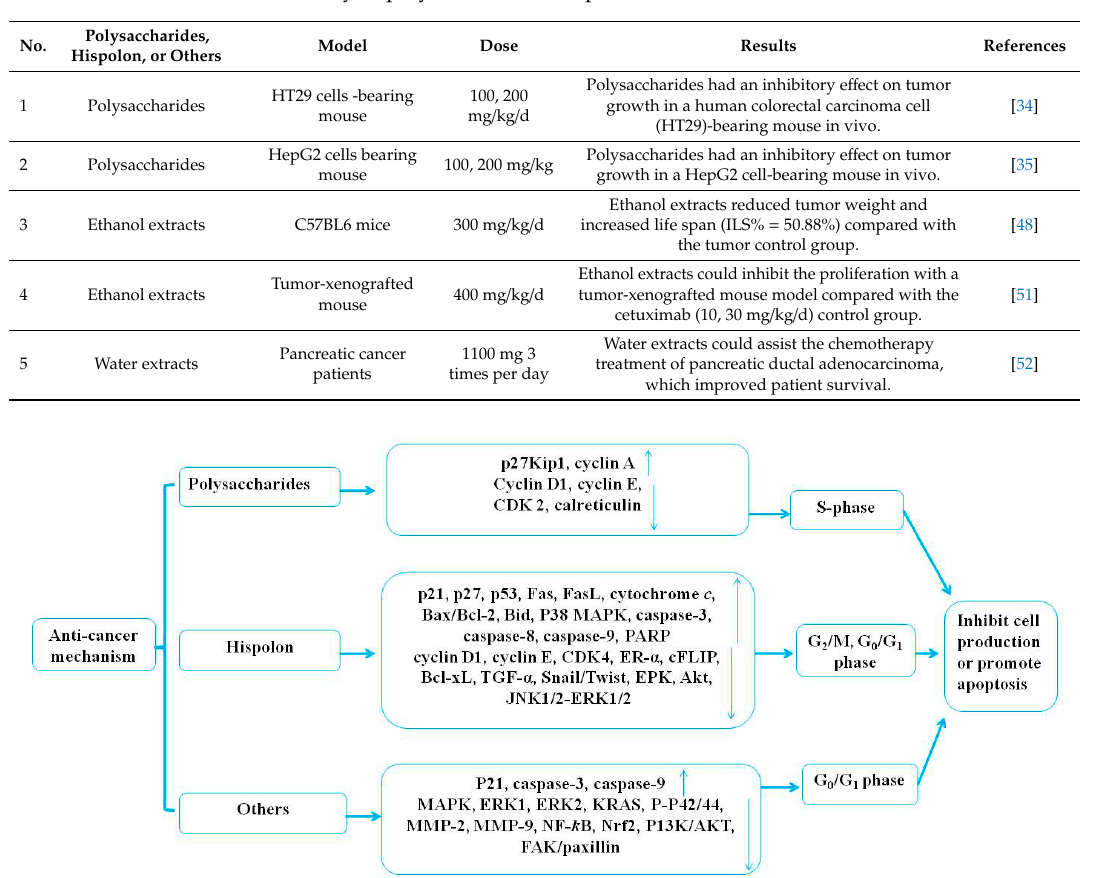
Table 3. The anticancer activity of polysaccharides, hispolon, or others from P. linteus in vivo studies.